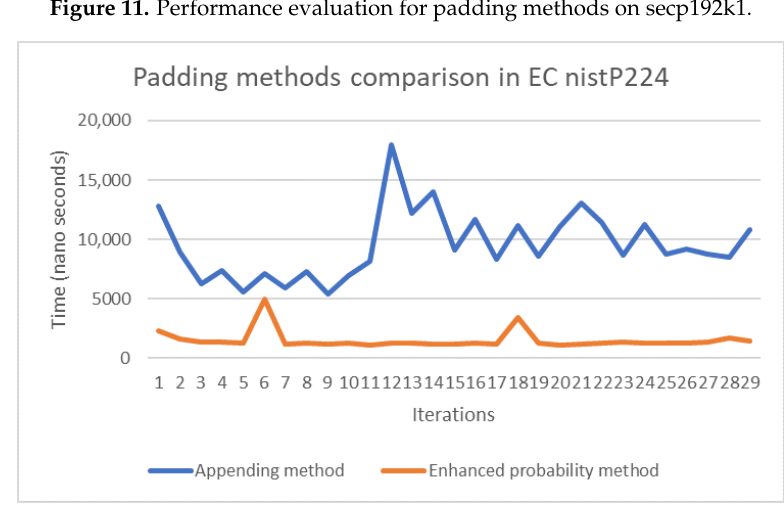
Figure 12. Performance evaluation for padding methods on nistP224.